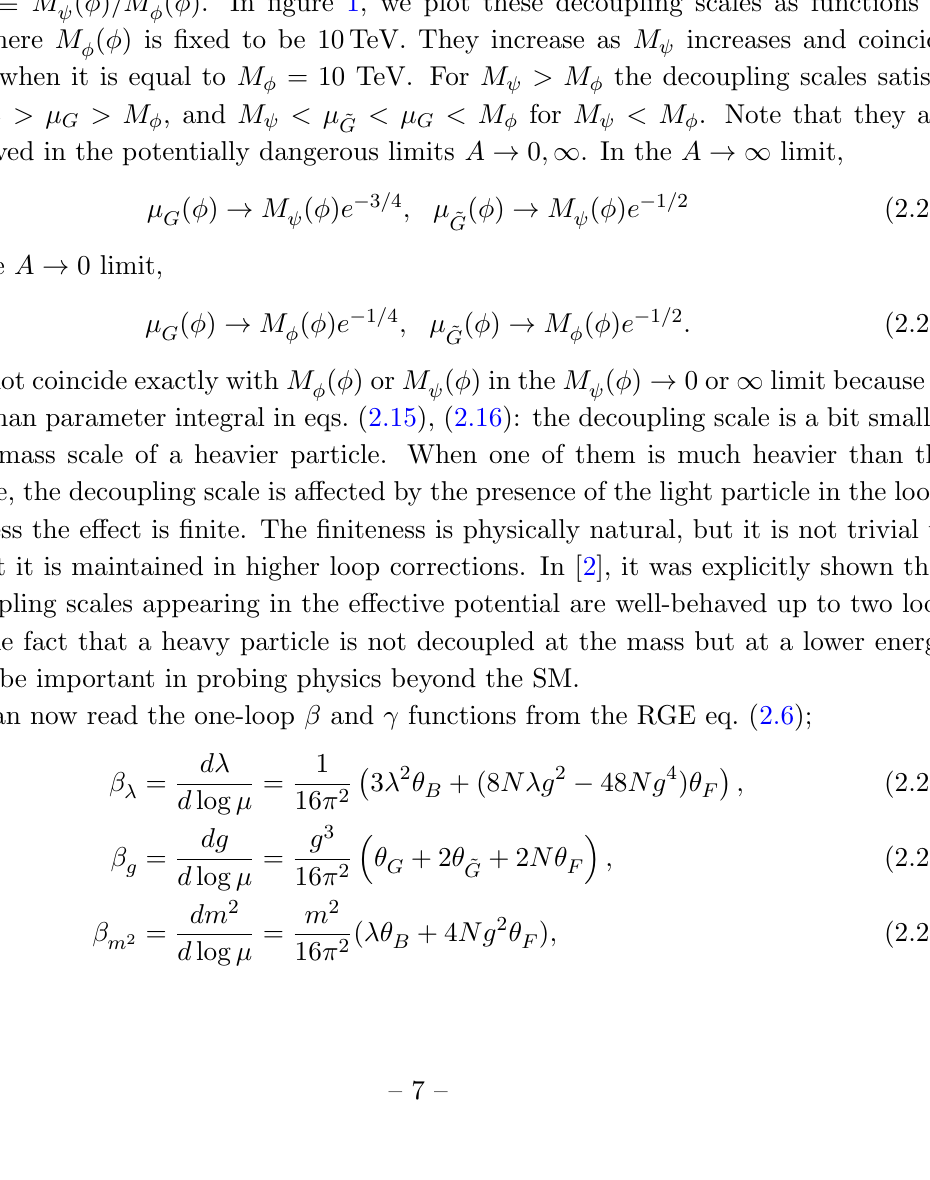
and (cid:22) as functions of M ( (cid:30) ). Here, M ~ G G